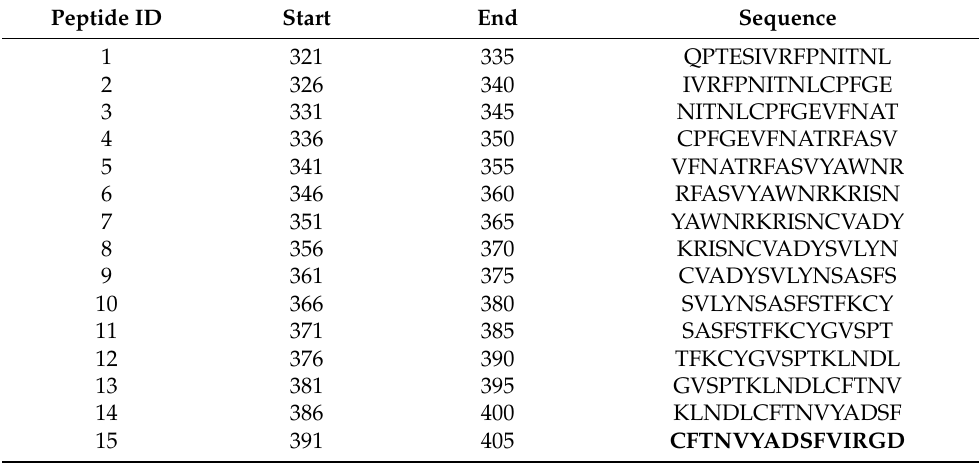
Table 1. List of tested 15-mer receptor-binding domain (RBD) peptides of SARS-CoV-2 spike